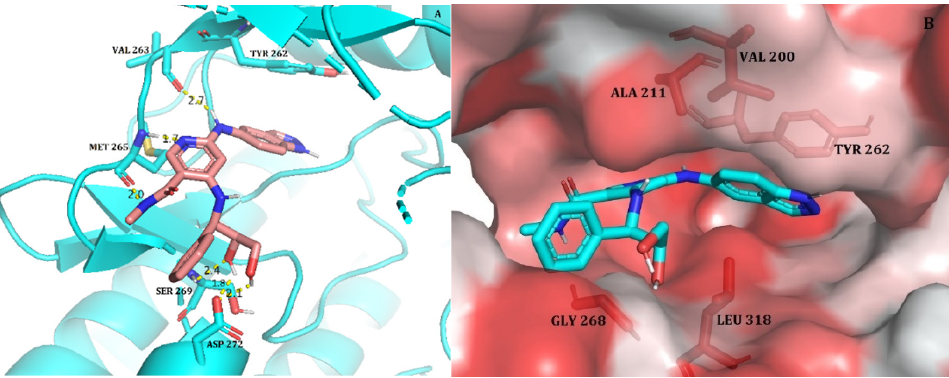
Figure 1. ( A ) Docked pose of the most active compound, 33, within the active site of IRAK4 (Hydrogen bonds are represented as yellow dotted lines); ( B ) The most active compound 33 (shown in stick model) within the hydrophobic pocket of IRAK4; the red coloured region represents the most hydrophobic surface of the protein, and the white colour represents the least hydrophobic surface. Hydrophobic residues are indicated with red sticks.